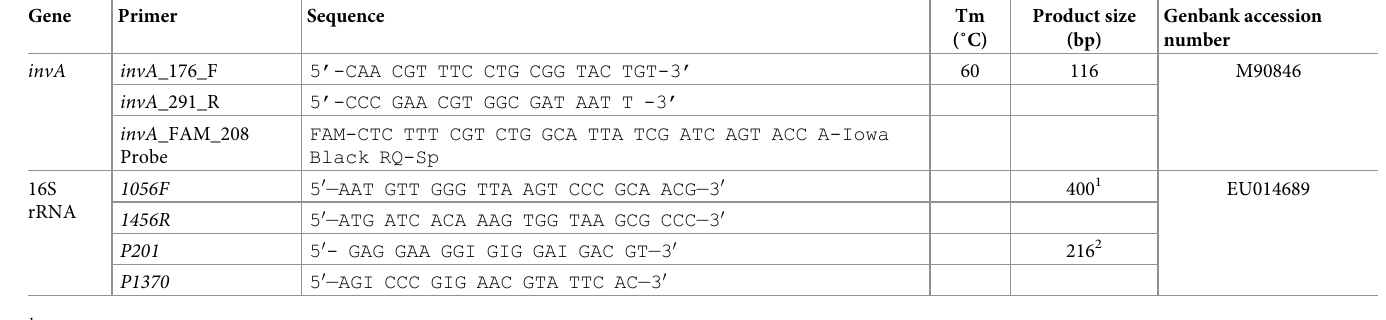
Table 1. Primers and probes used for